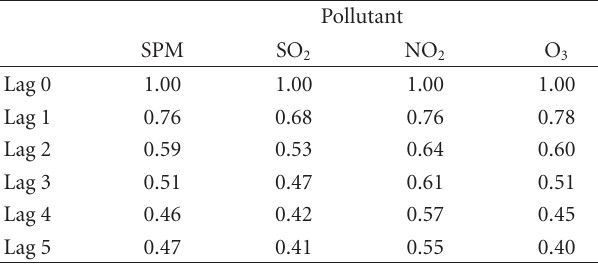
Table 2: Pearson correlation coe ffi cients between pollutants in di ff erent time